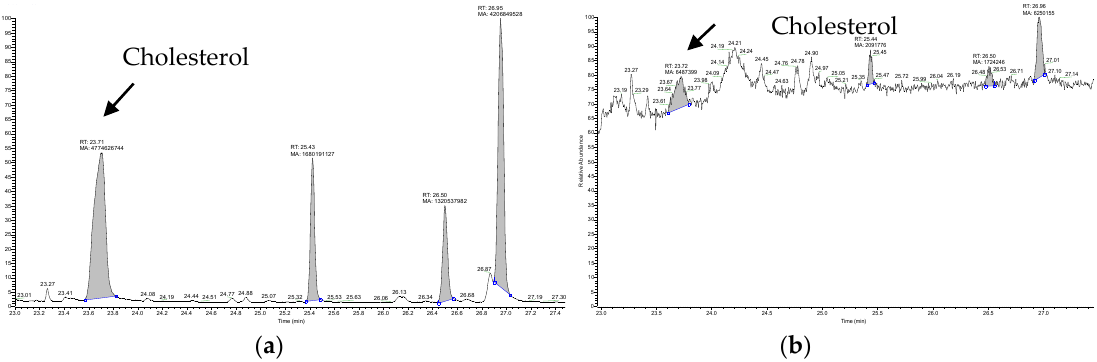
Figure 3. Fragments of chromatograms recorded in full spectrum scan mode obtained after the liquid-liquid extraction (LLE) ( a ) and the microextraction by packed sorbent (MEPS) ( b ) of the serum samples of a critically ill patient which indicate the content of interfering matrix components.